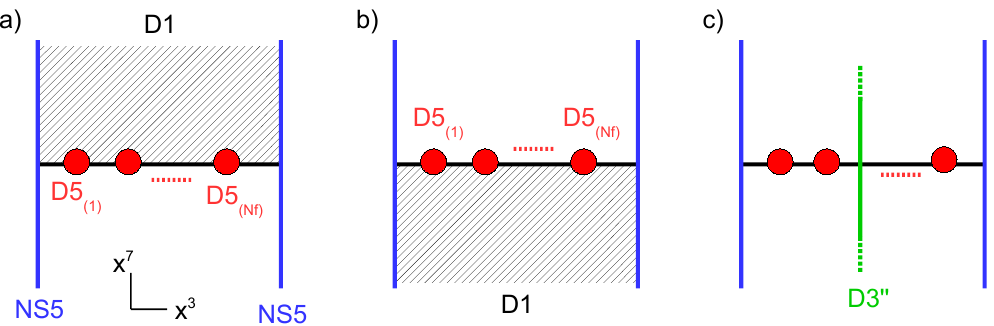
Figure 18 . a) Semi in(cid:12)nite D1 ending on the D3 from above, inserting the monopole operator u + . b) Semi in(cid:12)nite D1 ending on the D3 from below, inserting the monopole operator (cid:0) u (cid:0) . c) D3" brane crossing the D3 at an arbitrary position in x 3 between the two NS5s, inserting the complex scalar operator ’